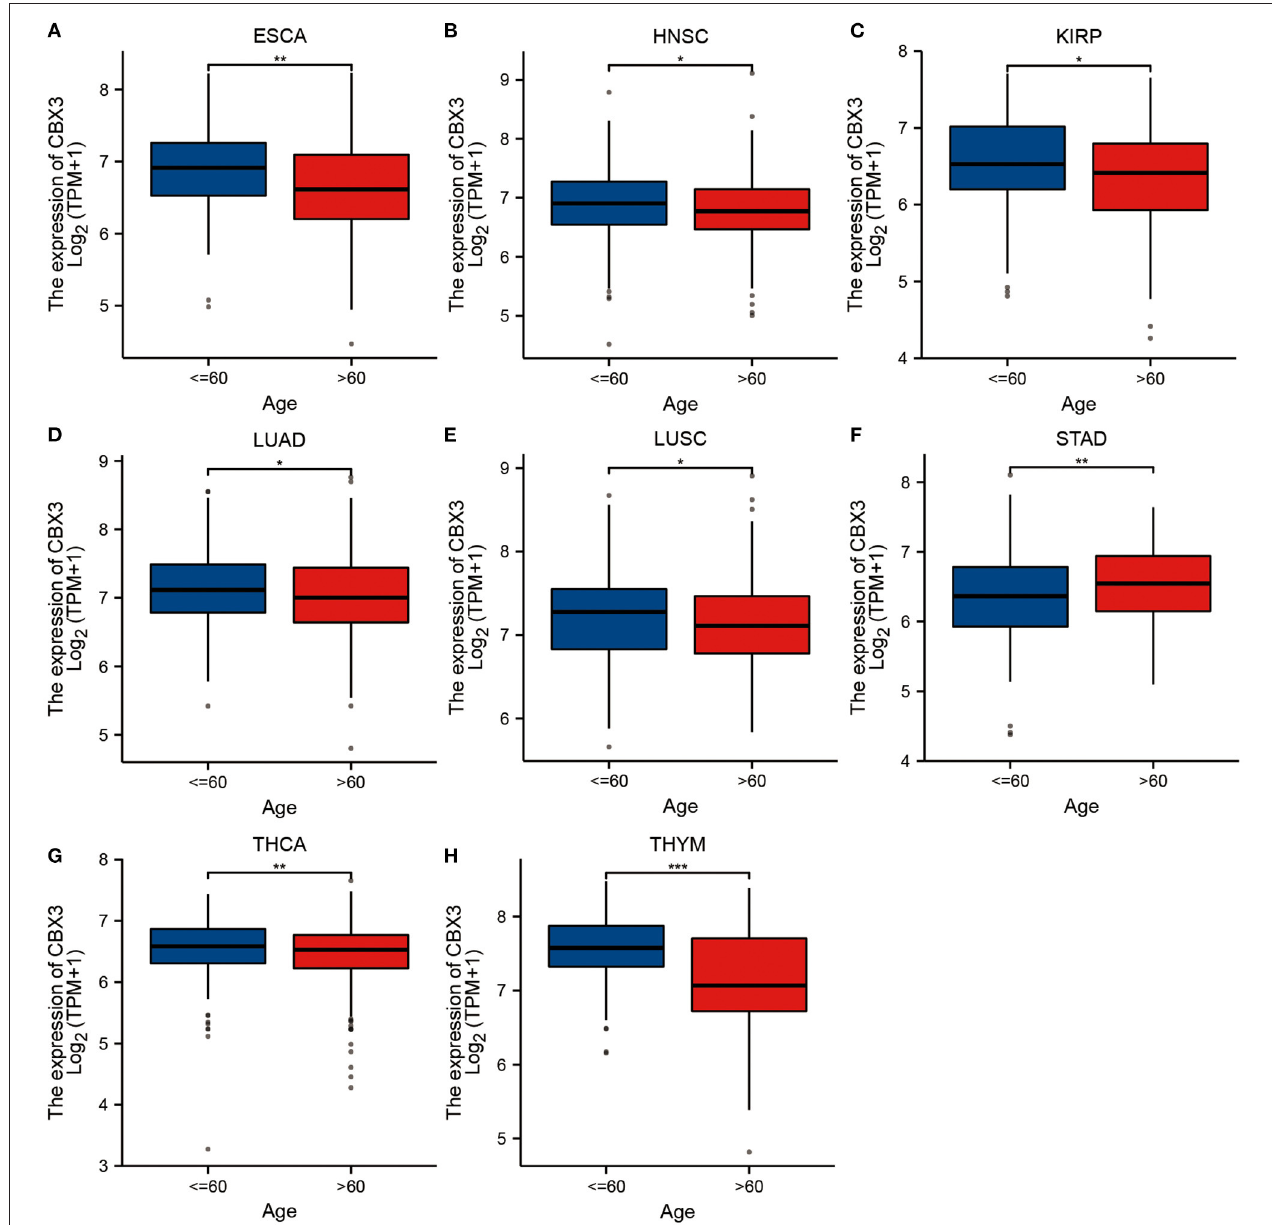
FIGURE 5 | Correlation of CBX3 expression with age in (A) ESCA, (B) HNSC, (C) renal papillary cell carcinoma(KIRP), (D) LUAD, (E) LUSC, (F) STAD, (G) THCA and (H) thyma.